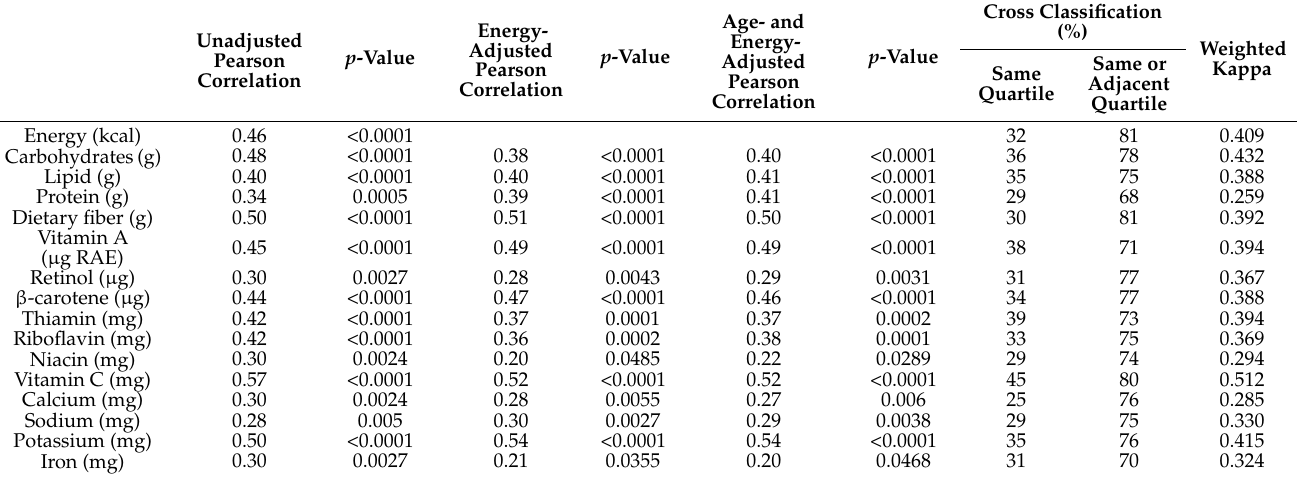
Table 5. Correlation coefficients and agreement for nutrient intake between FFQ and 3-day dietary records ( n =